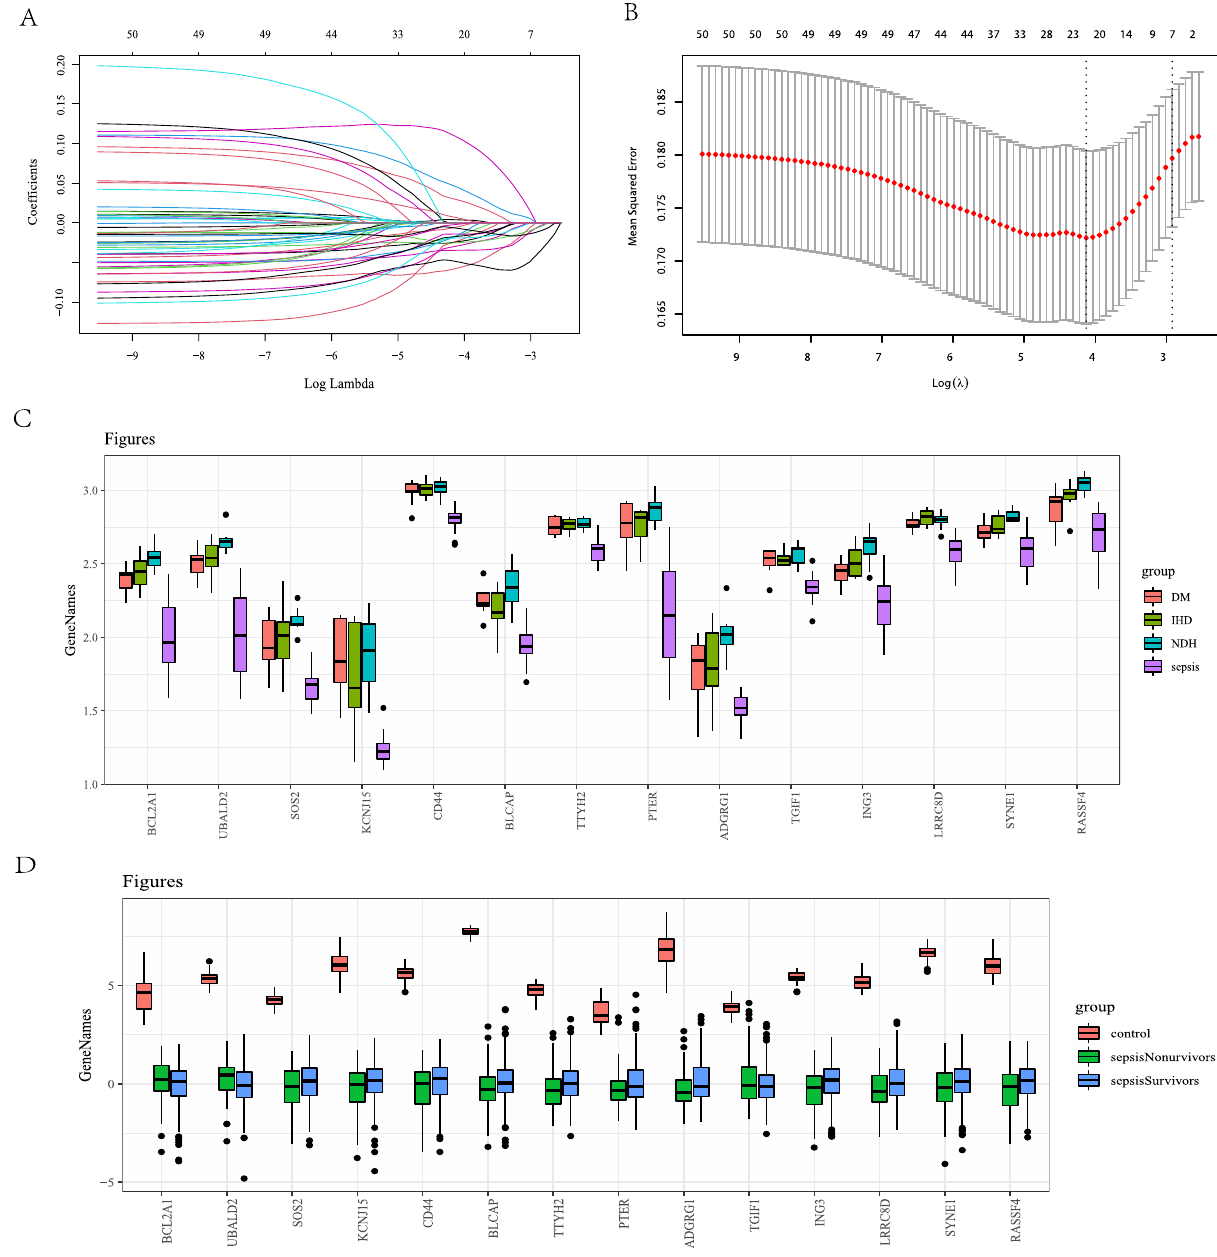
Figure 4. ( A ) Lasso regression of the variable selection. ( B ) The area of best λ values varies from 0.009211057 to 0.05394935, the best variable numbers should be in the area from 7–21. ( C ) Boxplot of hubgene expression in the myocardium with the data in GSE79962. ( D ) Boxplot of hubgene expression in the myocardium with the data in